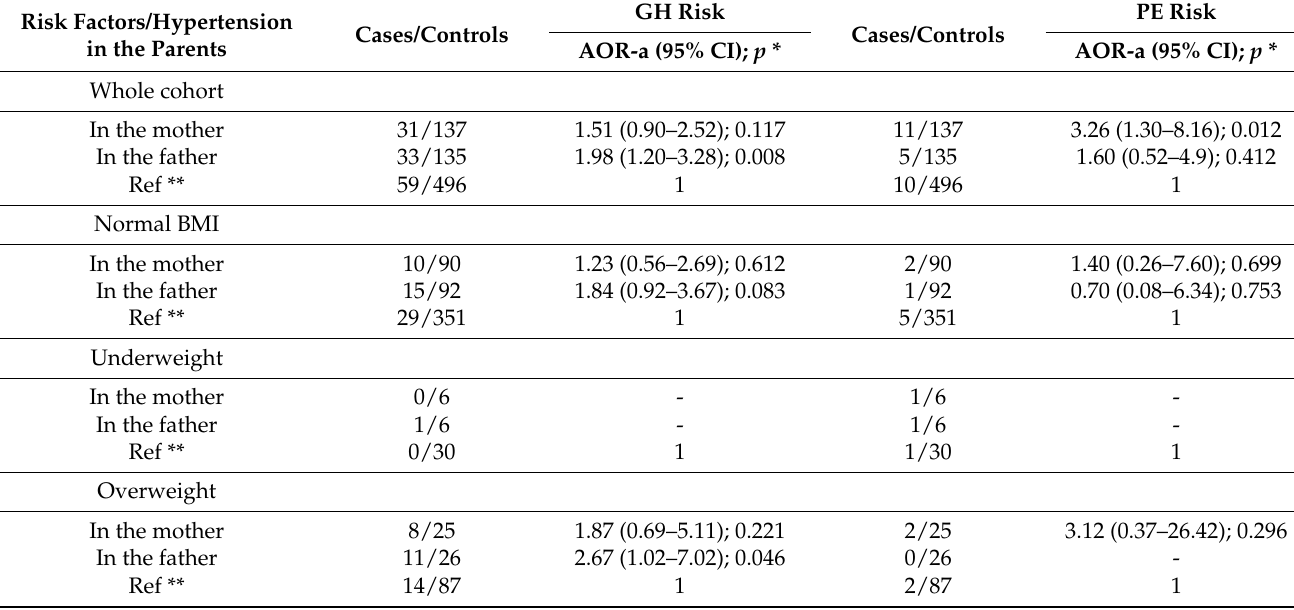
Table 5. Adjusted odds ratios for the association between paternal and maternal hypertension on gestational hypertension (GH) and preeclampsia (PE) in the subgroups of BMI or smoking